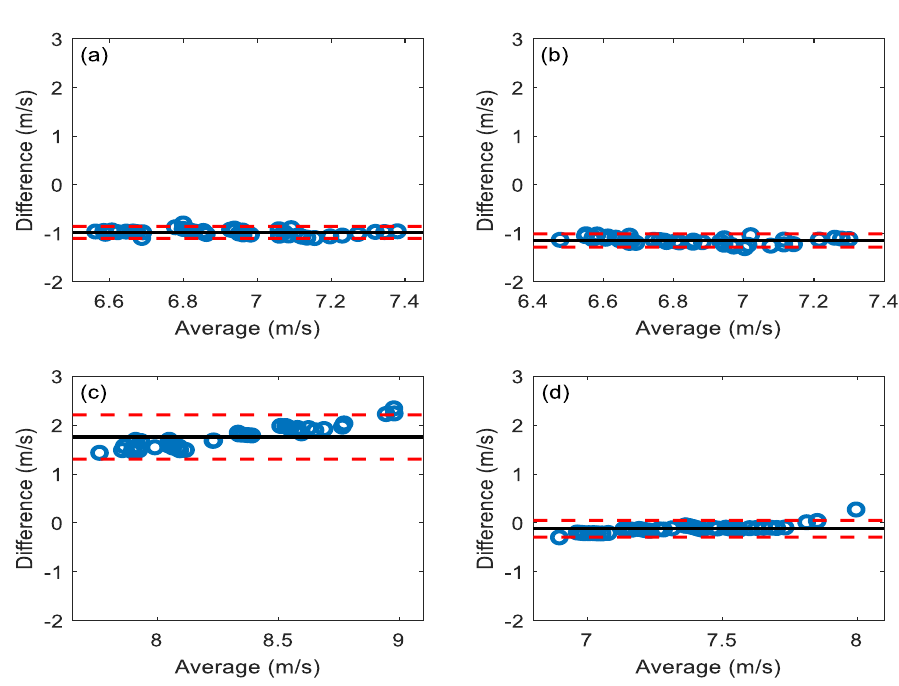
Figure 11. Bland–Altman comparisons of the reference cfPWV from the 1D model and the estimated cfPWV values of the four algorithms operating on the carotid and femoral pressure pulse waves from the 1D model: ( a ) Waveform matching; ( b ) Intersecting tangent; ( c ) Cross-correlation; ( d ) Tube-load model. The red dotted lines represent ± 1.96 standard deviation; the black solid line represents the mean